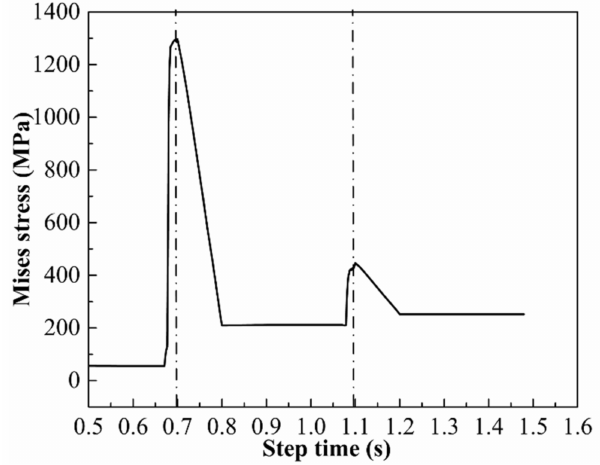
Figure 12. Variation in the curve of the Mises stress with the step